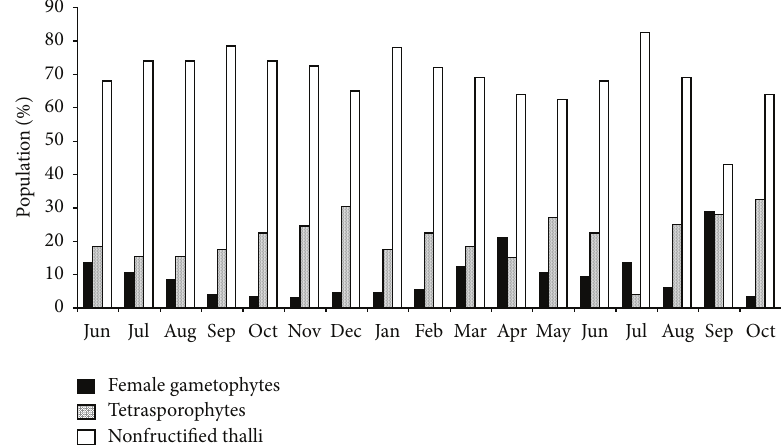
Figure 5: Population structure of Chondracanthus teedei var. lusitanicus in Buarcos bay.